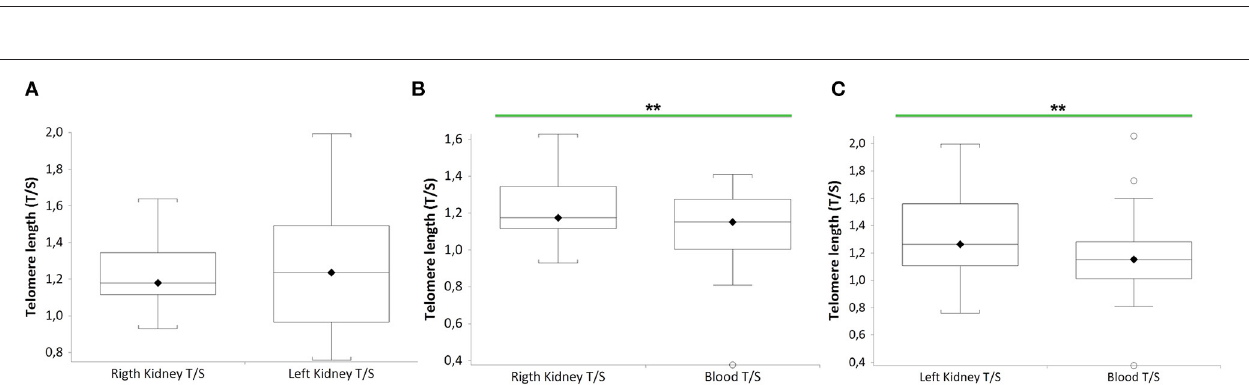
FIGURE 1 | DNAmAge and AgeAcc of both kidneys (right and left) and blood leukocytes in the same donors ( n = 27). Box plots show levels of DNAmAge in right and left kidneys (RK and LK) (A) , in RK and blood (B) , and in LK and blood (C) of the same donors. In box plots, the boundary of the box closest to the x-axis indicates the 25th percentile, the line within the box marks the mean, and the boundary of the box farthest from the x-axis indicates the 75th percentile. Whiskers (error bars) above and below the box indicate the 95 and 5th percentiles. In (B) , the horizontal bar with asterisk indicates the significant comparison between RK DNAmAge and paired blood DNAmAge of the same donor (n = 27) (*Paired t -test: median 69 years vs. median 65 years; p = 0.0271). In (C) , the horizontal bar with asterisk indicates the significant comparison between LK DNAmAge and paired blood DNAmAge of the same donor ( n = 27) (*Paired t -test: median 69 years vs. median 65 years; p = 0.0245). Box plots show levels of AgeAcc in right and left kidneys (RK and LK) (D) , in RK and blood (E) , and in LK and blood (F) of the same donors. In box plots, the boundary of the box closest to the x-axis indicates the 25th percentile, the line within the box marks the mean, and the boundary of the box farthest from the x-axis indicates the 75th percentile. Whiskers (error bars) above and below the box indicate the 95 and 5th percentiles. In (E) , the horizontal bar with asterisk indicates the significant comparison between RK AgeAcc and paired blood AgeAcc of the same donor ( n = 27) (*Paired t -test: median − 5 years vs. median − 8 years; p = 0.0271). In (F) , the horizontal bar with asterisk indicates the significant comparison between LK AgeAcc and paired blood AgeAcc of the same donor ( n = 27) (*Paired t -test: median − 6 years vs. median − 7 years; p = 0.0245).